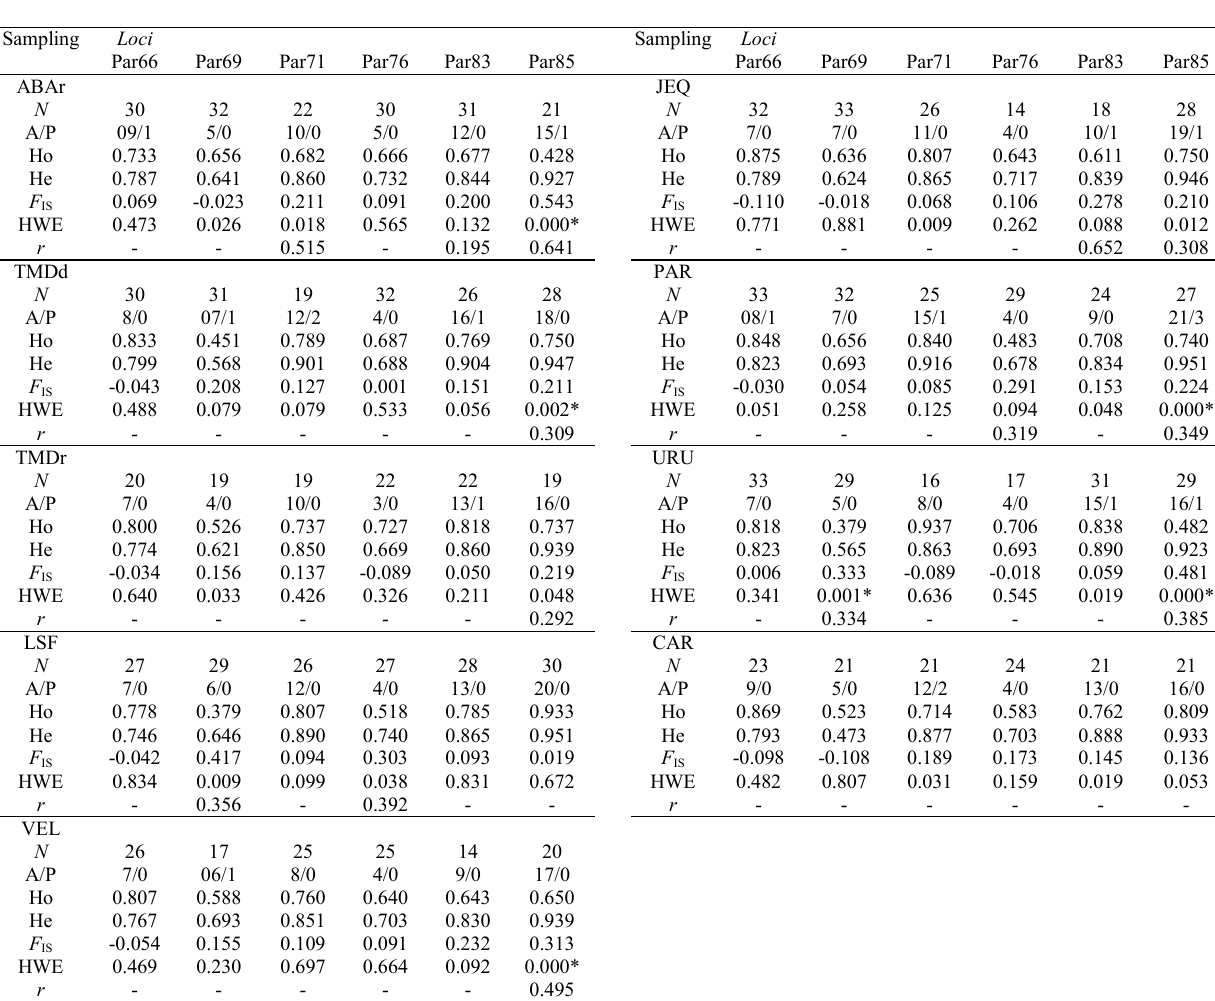
Table 2. Summary of the six microsatellite loci for each analyzed sampling of Prochilodus argenteus . N, number of individuals; A, number of alleles; P, number of private alleles; Ho, observed heterozygosity; He, expected heterozygosity; F coefficient; HWE, probability test for deviation from expected Hardy-Weinberg proportions, *, P-value = 0.05 (adjustment Bonferroni correction P < 0,008; K = 6); r , null alleles frequency per loci . ABAr = rio Abaeté at rainy season; CAR = rio Carinhanha lagoons; JEQ = rio Jequitaí lagoons; PAR = rio Paracatu lagoons; LSF = rio São Francisco lagoons; URU = rio Urucuia lagoons; VEL = rio das Velhas lagoons; TMDd = Três Marias Dam at dry season; TMDr = Três Marias Dam at rainy season.